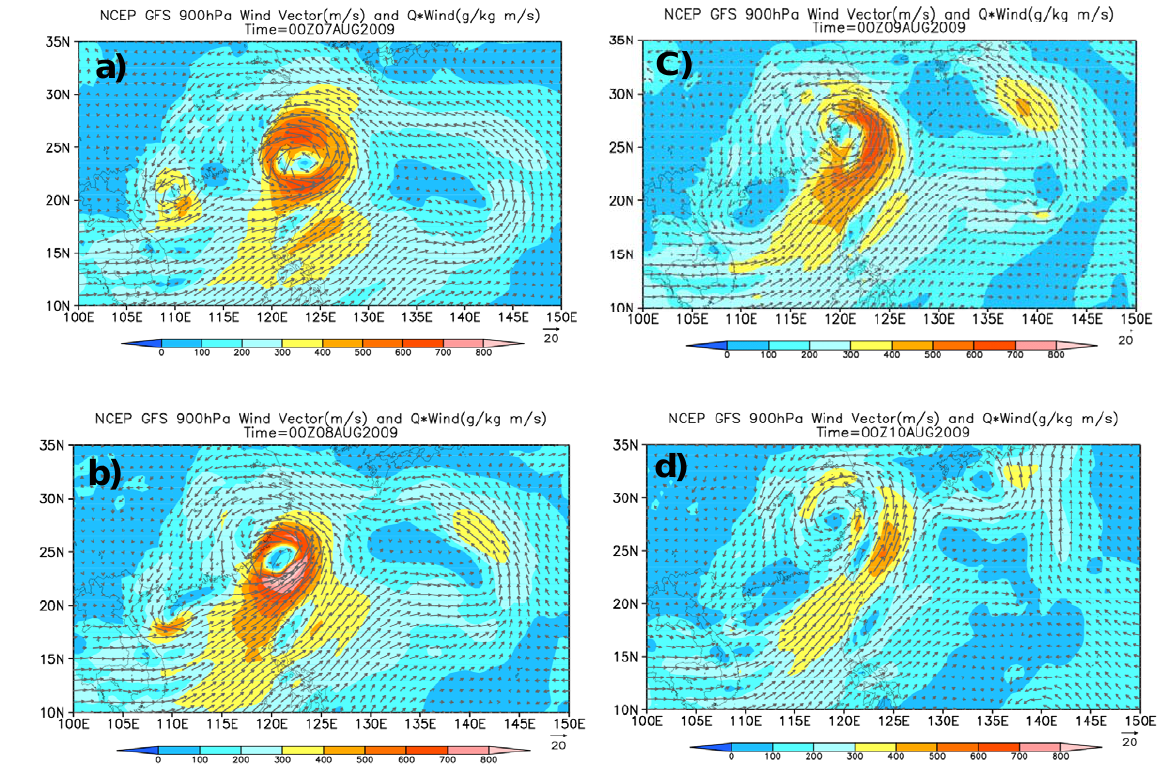
Fig. 3. (a) Moisture flux (colored) and wind field (arrow) deduced from NCEP GFS data at 900hPa level at 00:00UTC 7 August 2009. The colored scales represent the magnitude of moisture flux. The lower right corner of arrow denotes the scale of wind speed. (b) Same as (a) but for 00:00UTC 8 August 2009. (c) Same as (a) but for 00:00UTC 9 August 2009. (d) Same as (a) but for 00:00UTC 10 August,